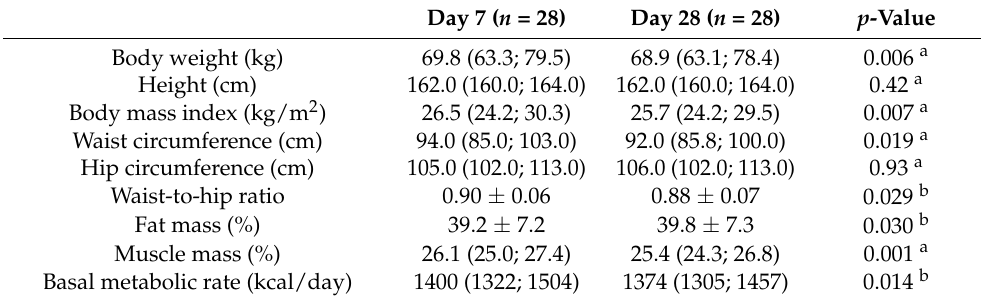
Table 2. Comparison of maternal anthropometric parameters from day 7 to day 28 of